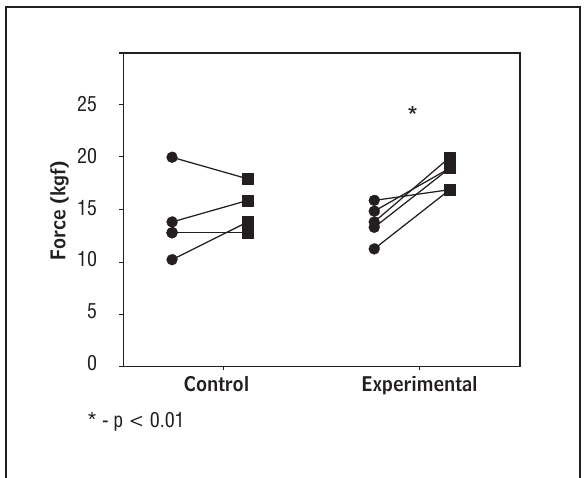
Figure 2 - Muscle strength before and after training